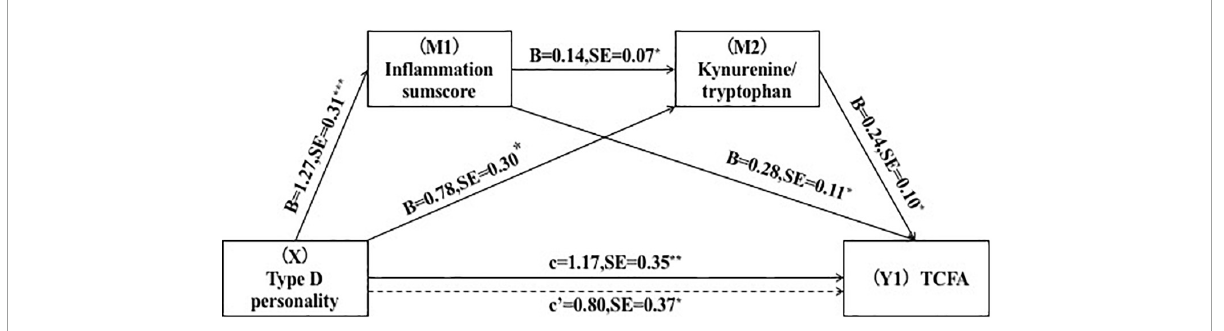
FIGURE2 Serial-multiple mediation of inflammation and kynurenine/tryptophan ratio in the relationship between Type D personality and TCFA. * p < 0.05, ** p < 0.01.